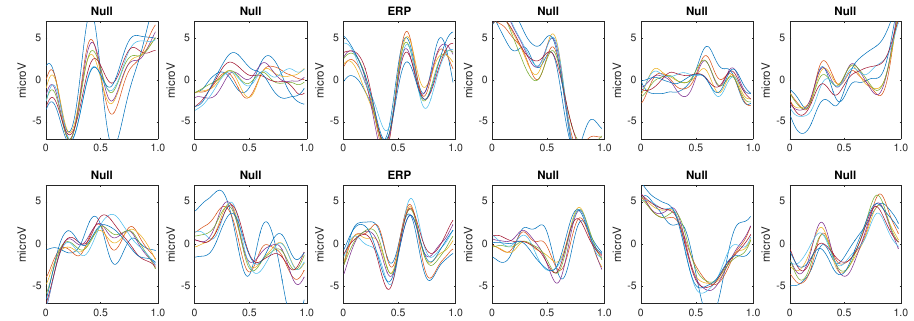
Figure 4. Point-to-point averaged signals. These are extracted from the first letter identification trial of the Subject 1 of the pseudo-real dataset. The ERP is superimposed on classes 3 and 9. Class 3 is obtained while averaging the segments where the row of the speller matrix is intensified whereas class 9 is calculated from the intensification of the corresponding